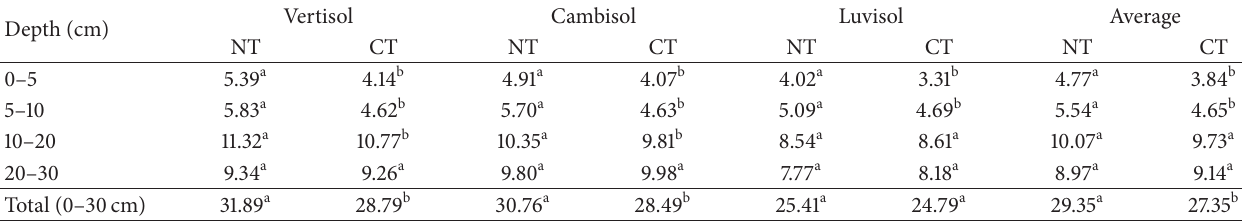
Table 2: Soil organic carbon storage (SOCs) (Mg ⋅ ha −1 ) in three sites under no tillage (NT) and conventional tillage (CT) in Merchouch, Morocco.